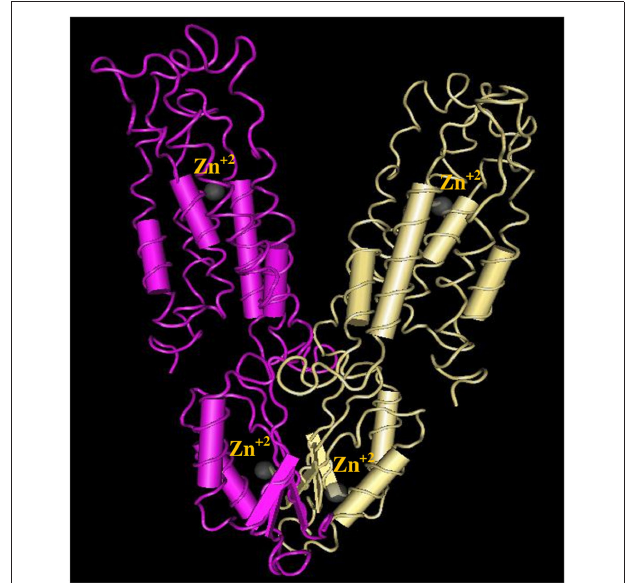
FIGURE 8 | Three-dimensional structures of Fief with 4 Zinc + 2 ions obtained from http://www.ncbi.nlm.nih.gov/Structure/VAST.